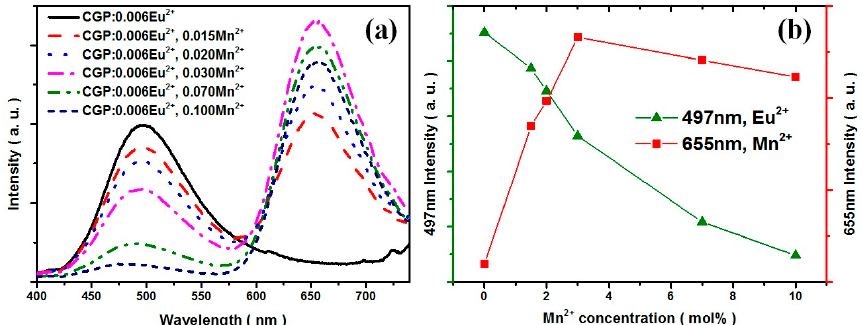
Figure 4. ( a ) The emission spectra of CGP:0.006Eu 2+ , x Mn 2+ ( x = 0–0.1) phosphors under the excitation of 380 nm; ( b ) The emission intensity of Eu 2+ (monitored at 497 nm) and Mn 2+ (monitored at 655 nm) versus Mn 2+ concentrations.